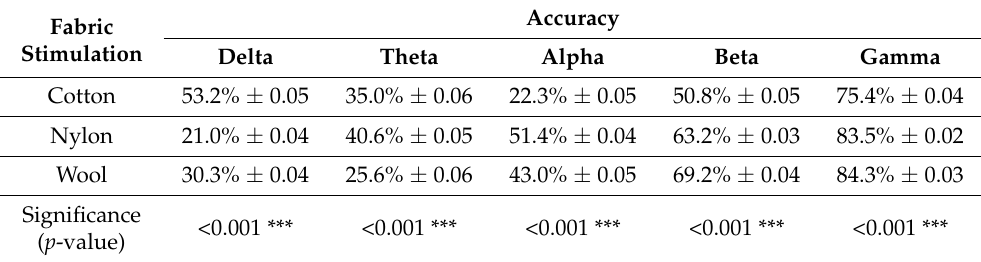
Table 4. Overall accuracies of the SVM-ML model for classifying different fabric